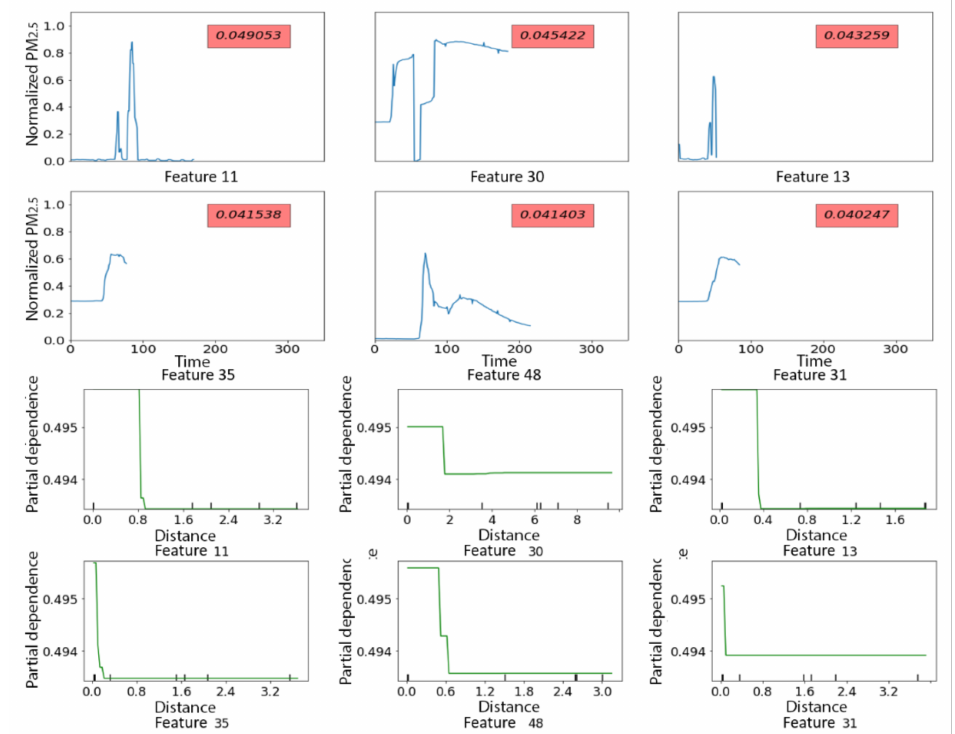
Figure 11. Top 6 shapelets predicting indoor vs. outdoor PM 2.5 in PRISMS. Top panels display the shapelets along with their feature importance and bottom panels display partial dependence plots with x-axes representing the minimum distance to the shapelet and y-axies representing predicted probability of indoor (vs.